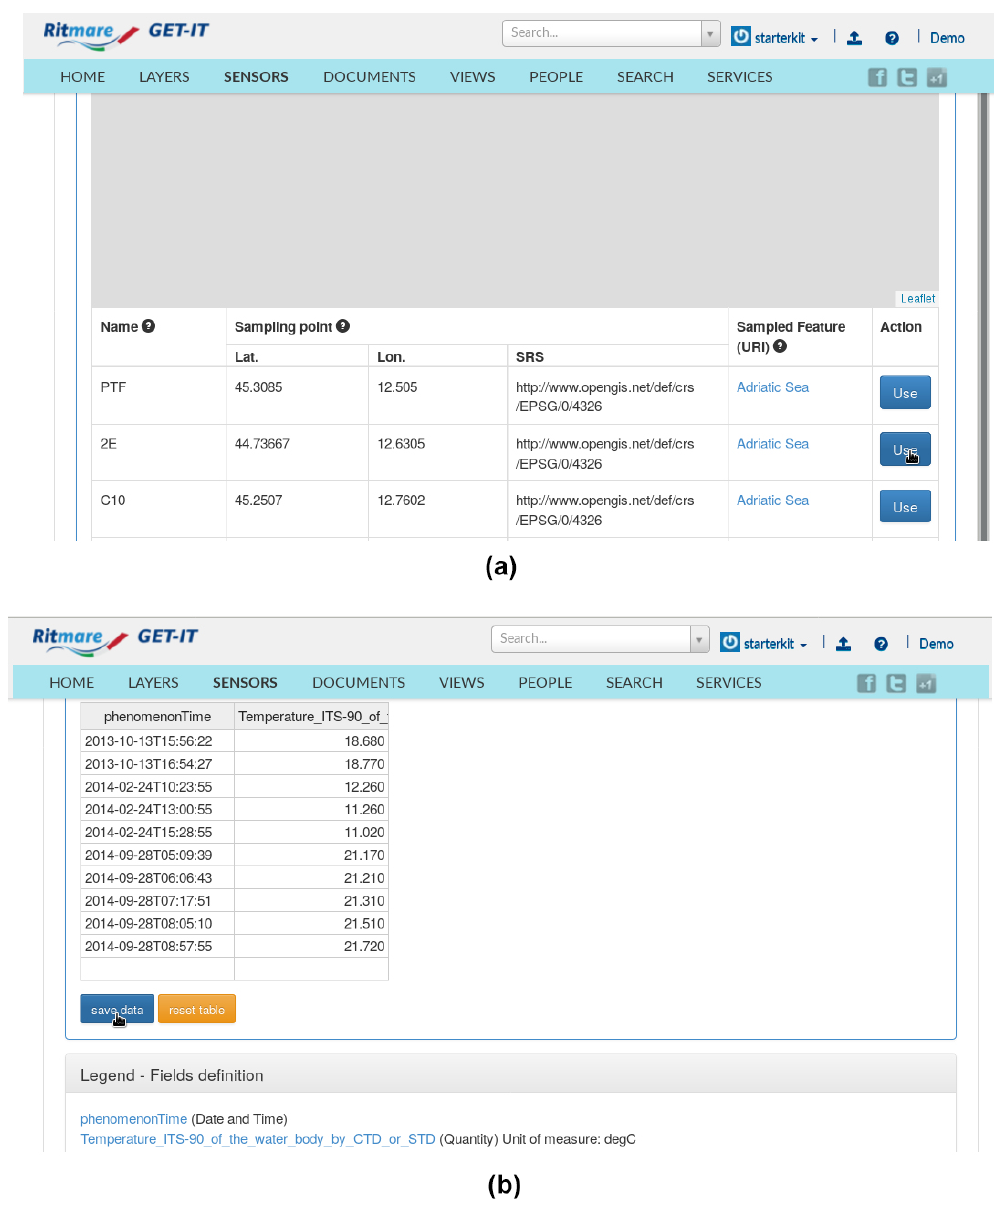
Figure 8. Data upload from the graphic interface. Selection of the sampling station for the specific sensor (a) and format of data to be uploaded into the SDI (b)